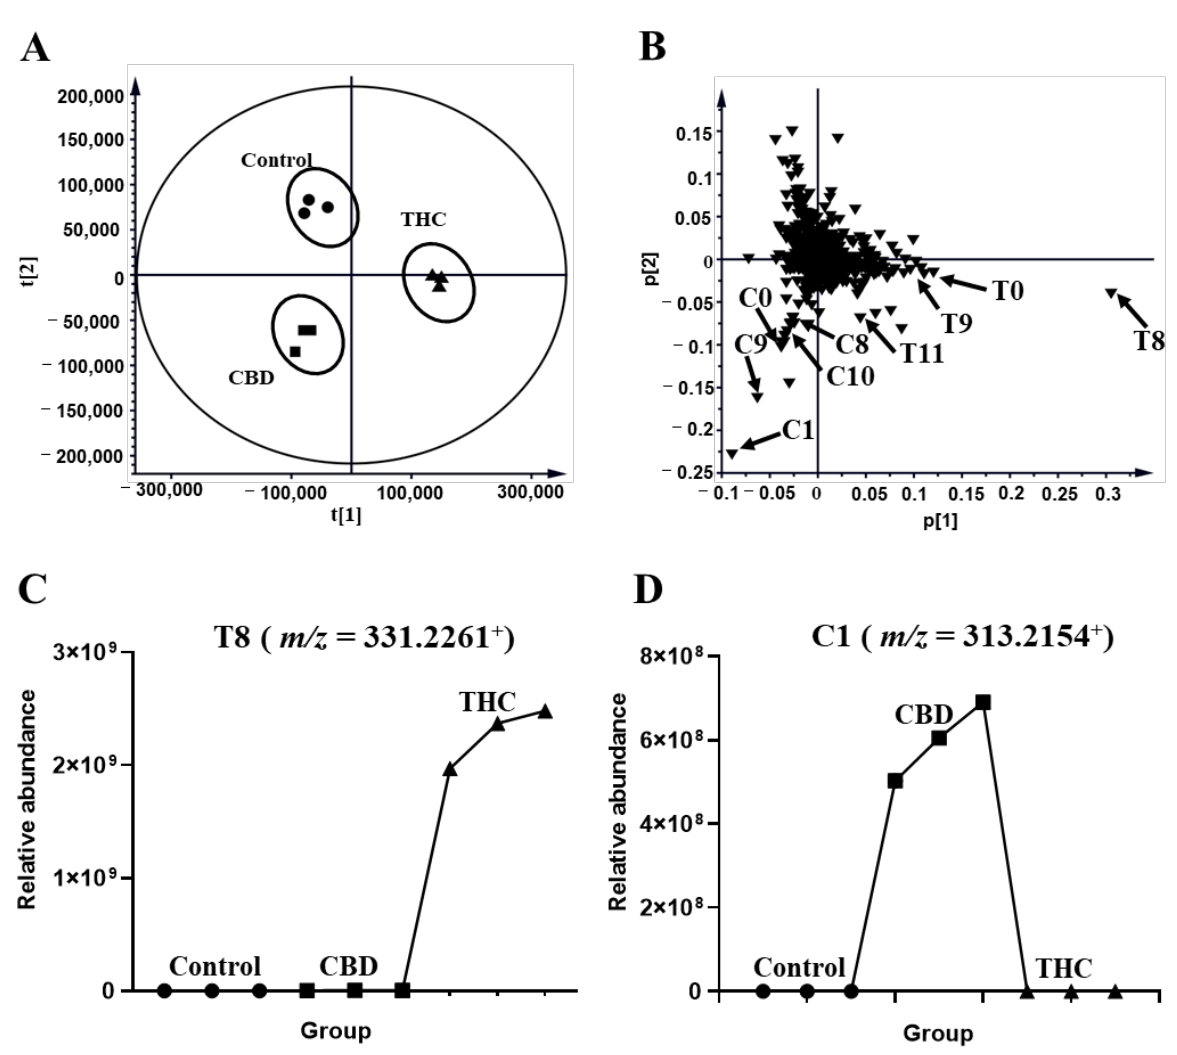
Figure 2. Metabolomic analysis of THC and CBD in the HLM incubation system. ( A ) Scores plot of unsupervised PCA showing the control (●), CBD ( ■ ), and THC ( ▲ ) treated HLM profiles ( n = 3). ( B ) Loading scatter plot for the control, THC, and CBD treated HLM profiles ( n = 3). Partial THC (T0, T4, T8–T9, T11, T17) and CBD (C0, C1, C8, C9, C10) metabolites are labeled in the Loading Scatter plot. The trend plot of T8 ( C ) and C10 ( D ) was showed in the control, CBD, and THC groups.